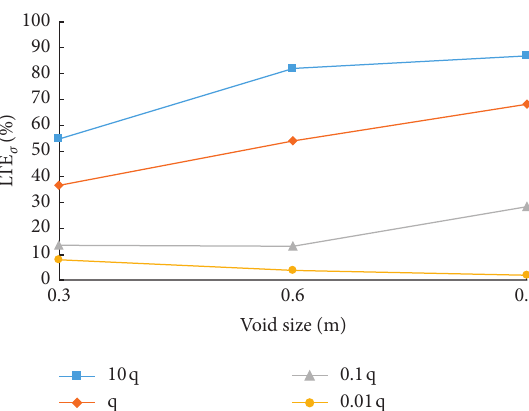
Figure 16: Relationship between void size and LTE